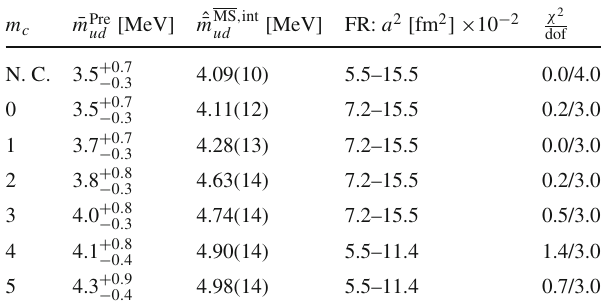
Table 18 Comparing the interpolated results ˆ¯ m MS , int Table19 at the continuum ud limit with the prediction ¯ m Pre together with the fitting results ud